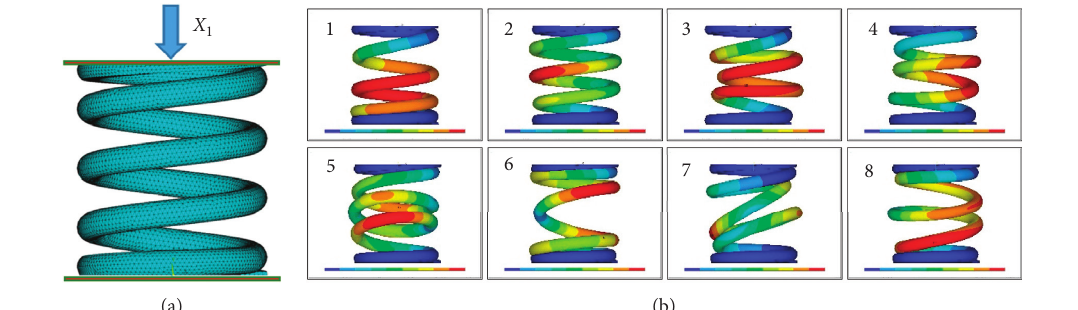
Figure 5: The FEM model and constrained modes of the coil